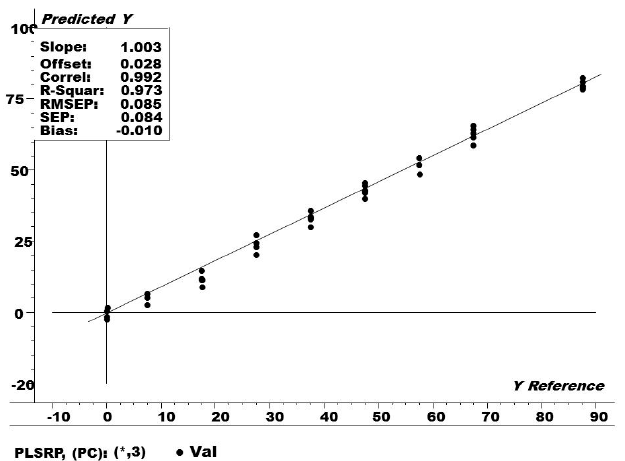
Figure 4. Measured vs predicted PLSR plot for the test set of the ca ff eine standards. RMSEP = root mean square error of prediction, while PLSP = partial least square regression curve of